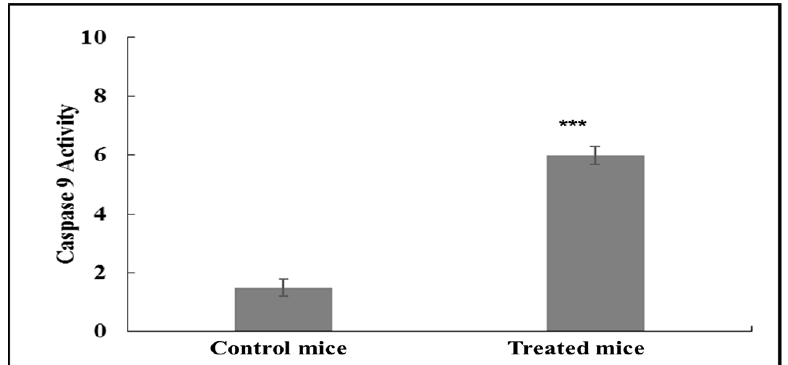
Figure 2. Activation of caspase-9 was measured by a fluorometric assay. Nude mice tumors treated with asiaticoside. Data represent the mean ± SD of six independent experiments. *** p < 0.0001 as compared to controls.